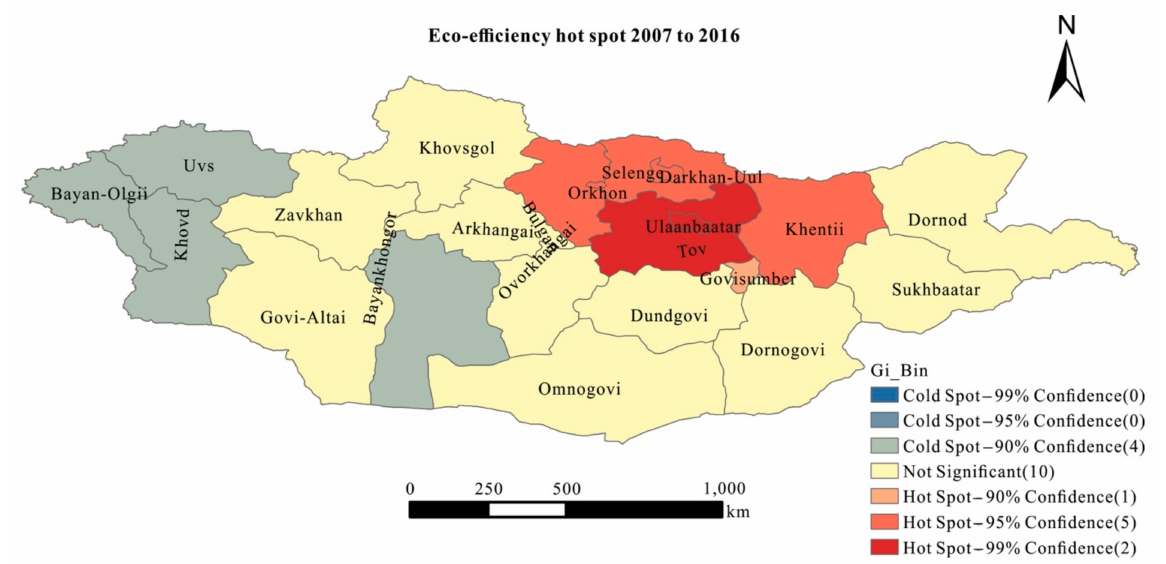
Figure 4. Mongolian eco-efficiency hot spot from 2007 to 2016.